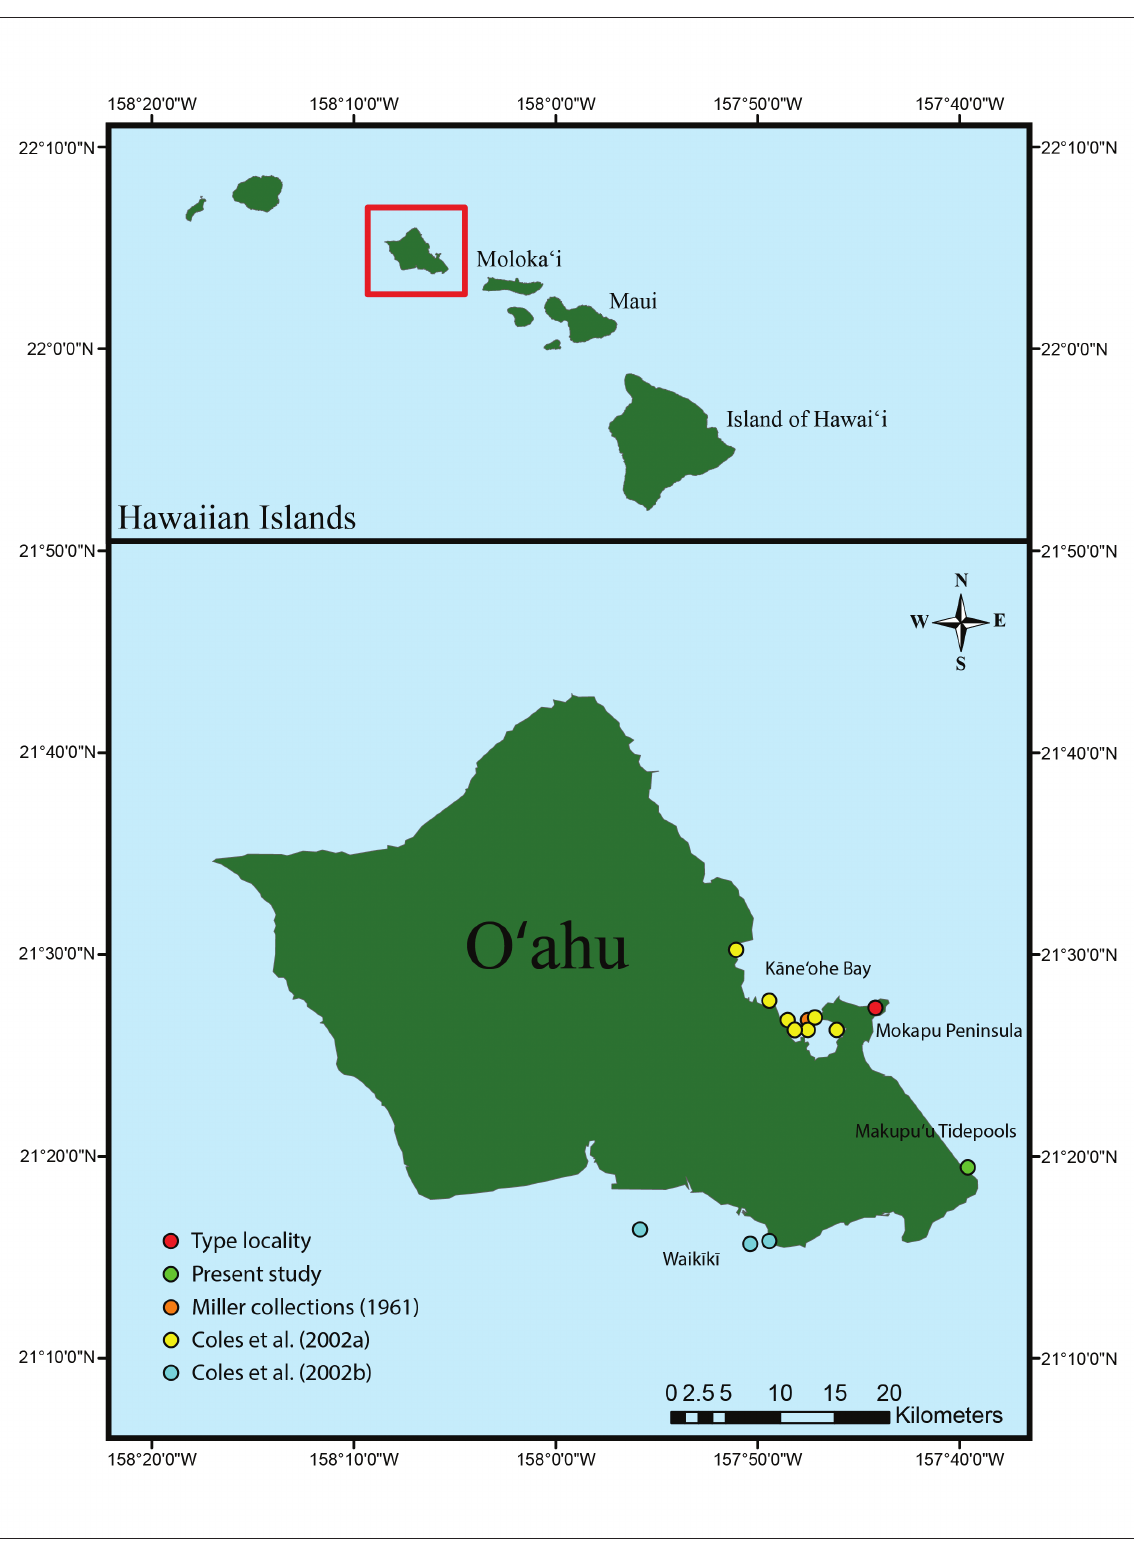
Figure 1. Map of O‘ahu Island, indicating where Brachylicoa lui sp. n. was found. Antennule (Fig. 3A). Peduncle article-1, 3.7 times